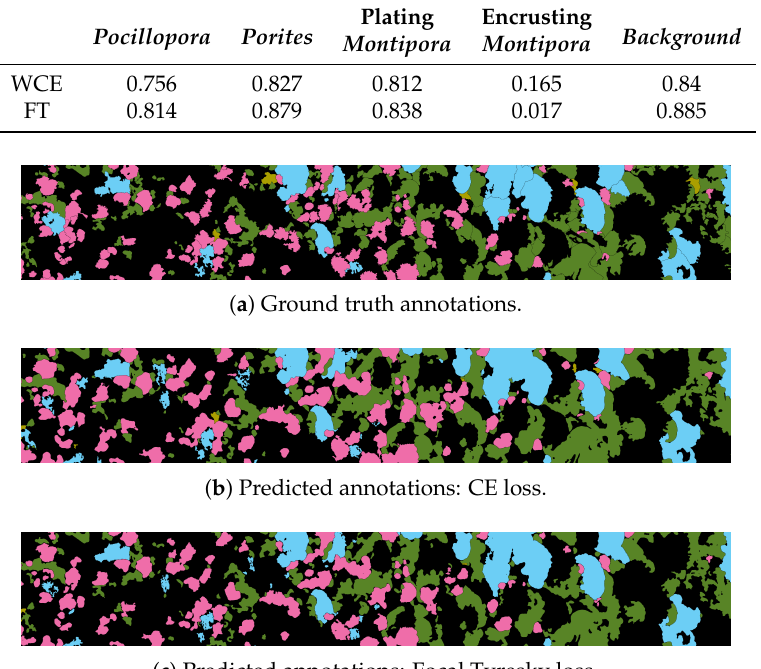
Table 4. Annotations overlap (express as IoU) between GT and prediction on the FLI test area, Figure 6.